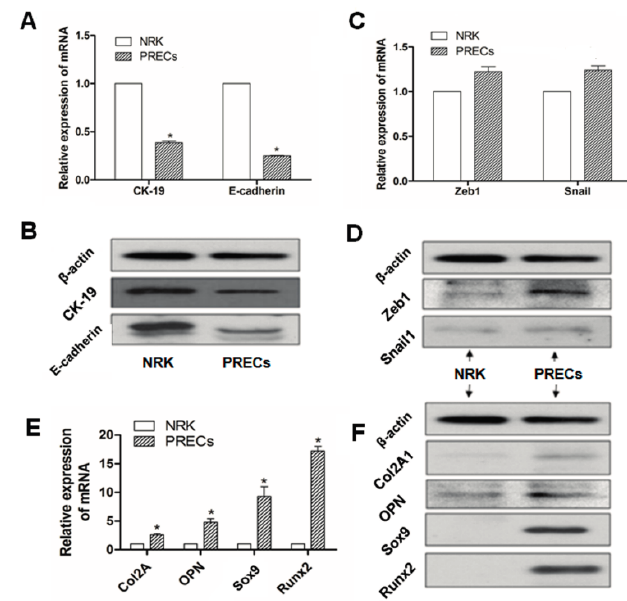
Figure 2. Representation of the relative mRNA ( A ) and protein expression ( B ) of epithelial phenotypic markers (E-cadherin, CK19); MSC phenotypic markers (Zeb1, Snail1) ( C , D ); and osteochondral markers (Col2A1, OPN, Sox9, Runx2) ( E , F ); in PRECs compared with NRK cells, * p < 0.05 ( n =